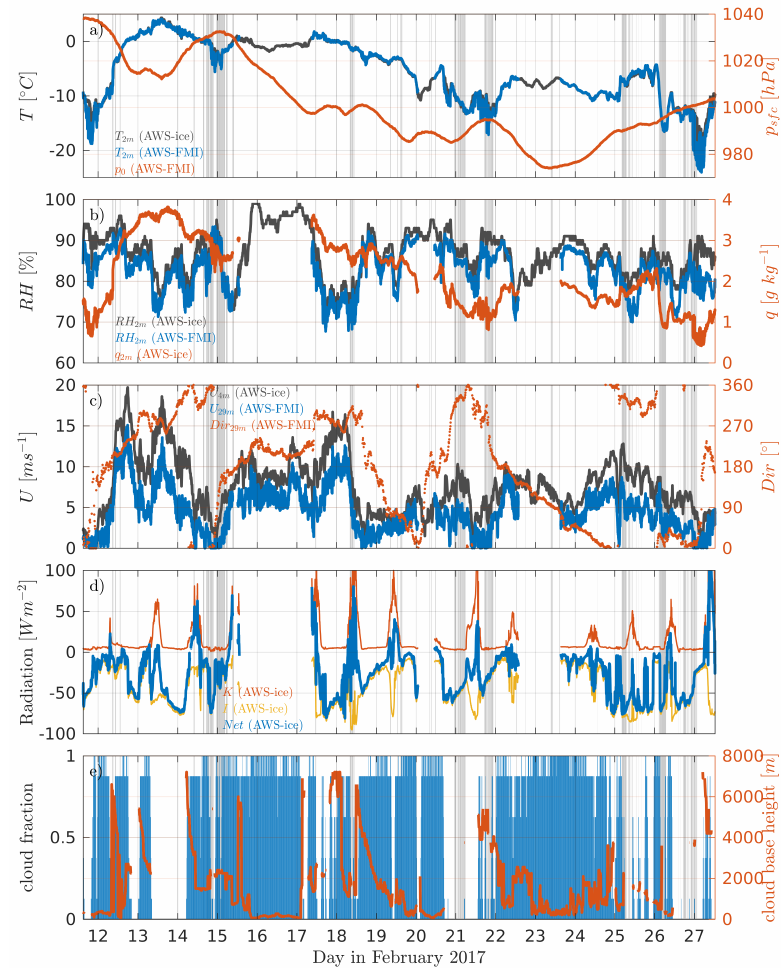
Figure 6. Overview of the meteorological conditions: ( a ) temperature, T , and surface pressure, p ; ( b ) relative, RH , and specific humidity, q ; ( c ) wind speed, U ; and direction, Dir ; ( d ) short-wave, K , long-wave, I , and net radiation balance, Net ; ( e ) total cloud fraction and cloud base height. Gray shading indicates times of UAV operation. Note that the wind measurements over land were performed at 29m above